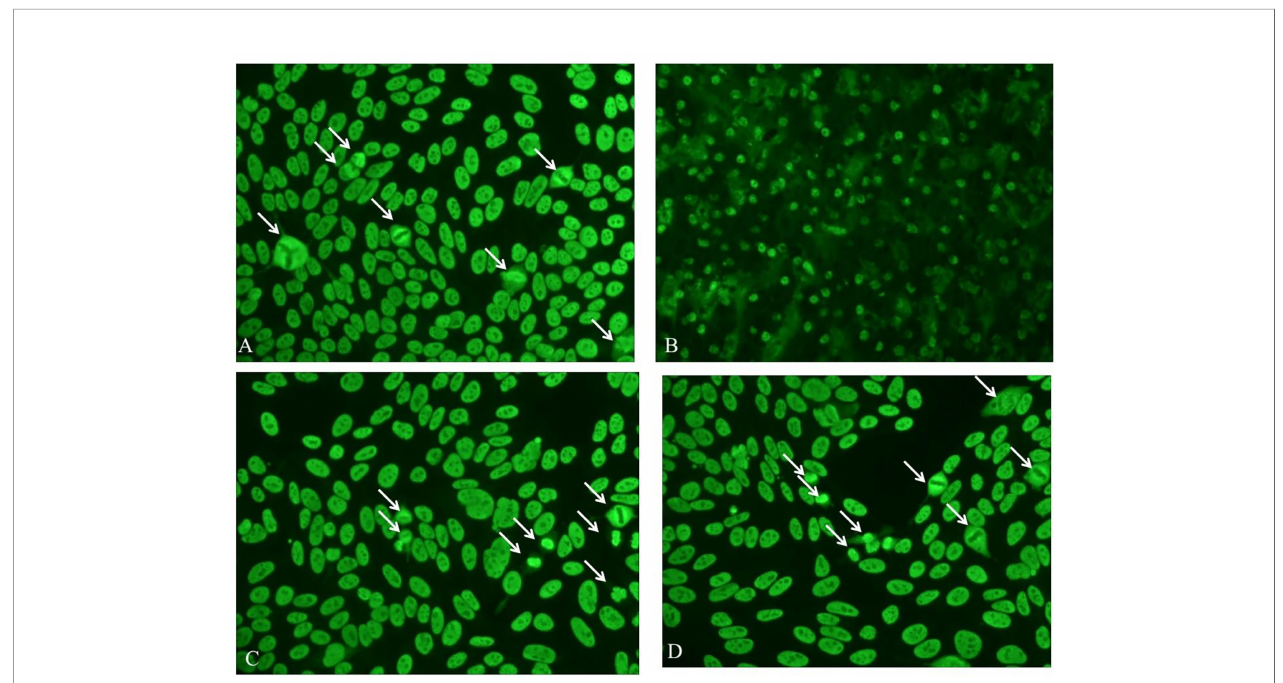
FIGURE 1 | Immuno fl uorescence patterns of the 50-year-old DM patient by IIF, diluted 1:100, on the liver cryostat sections of mouse (B) and on Hep-2 cells (A, C, D) . White arrow-marked mitotic cells (metaphase, anaphase, and telophase) had the chromatin mass stained or not